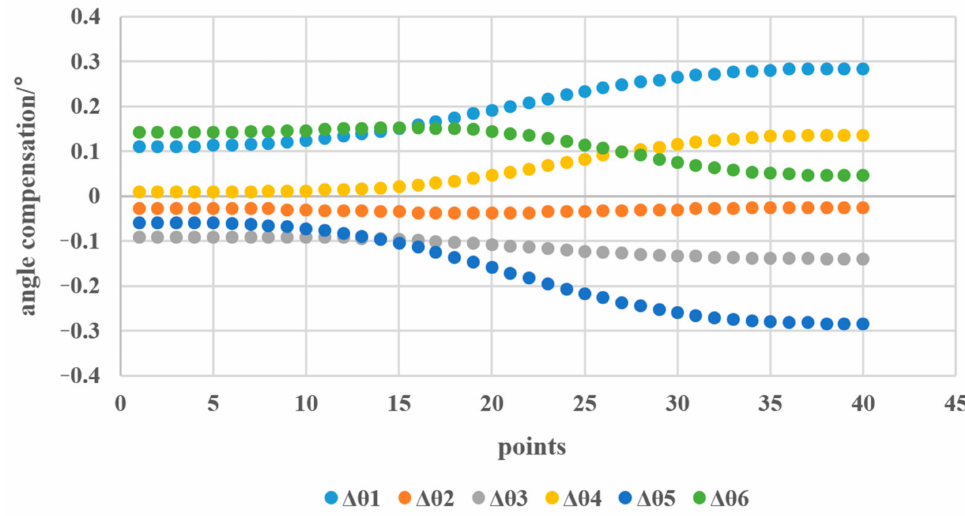
Figure 8. Compensated angles for joint angle θ 1 ∼ θ 6 .